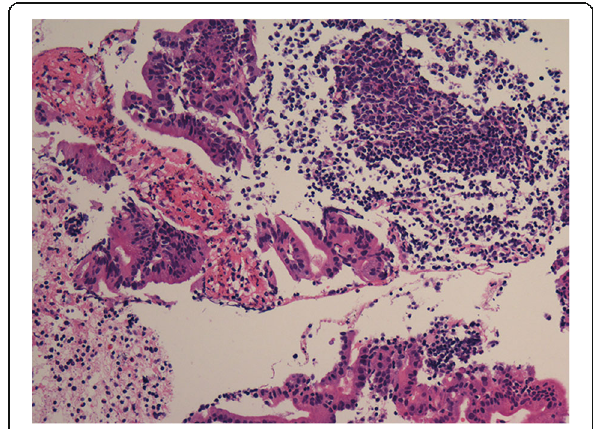
Fig. 3 Histopathological findings of suspicious adenocarcinoma cells, H&E stain, magnification × 200